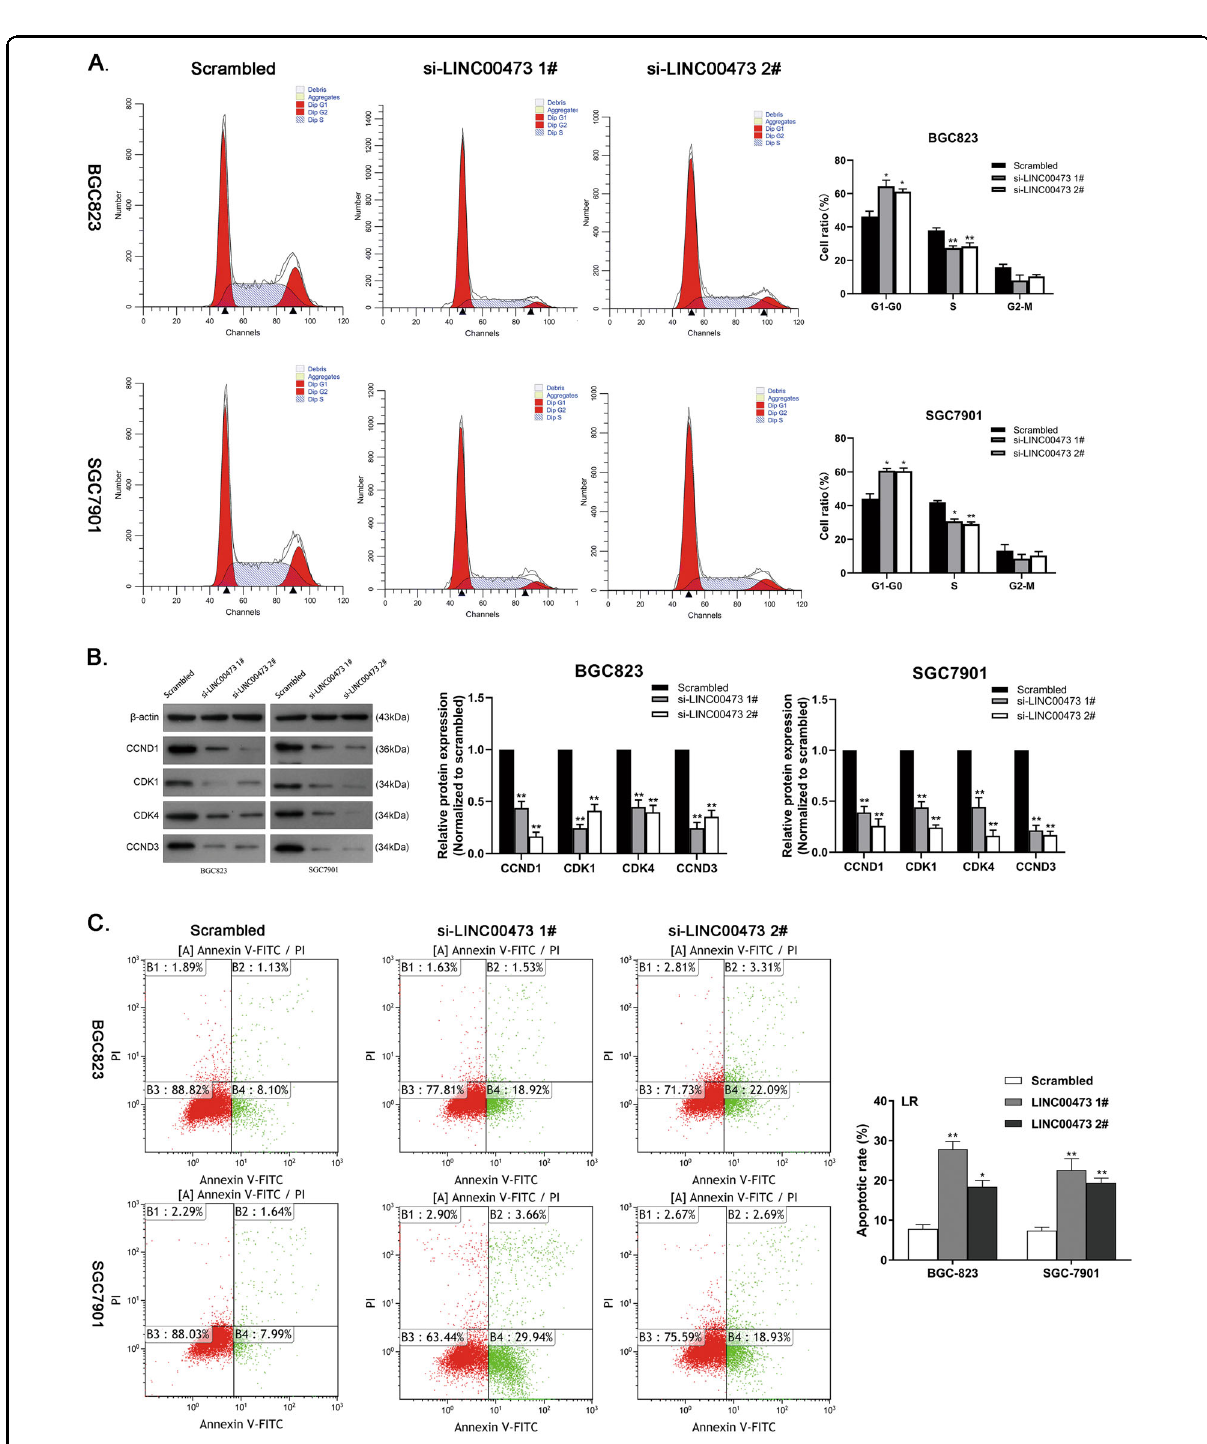
Fig. 3 Effects of LINC00473 on the cell cycle and apoptosis. A Cell cycle was determined in BGC823 and SGC7901 cells transfected with si- LINC00473. B The protein expression of cell cycle-related genes in BGC823 and SGC7901 cells transfected with LINC00473 siRNAs or scrambled were tested by western blot assays. β -actin protein was used as an internal control. C Apoptotic rates of BGC823 and SGC7901 cells transfected with LINC00473 siRNAs or scrambled were tested by fl ow cytometry. LR early apoptotic cells. Values are shown as the mean ± SD based on three independent experiments. * P < 0.05, ** P <